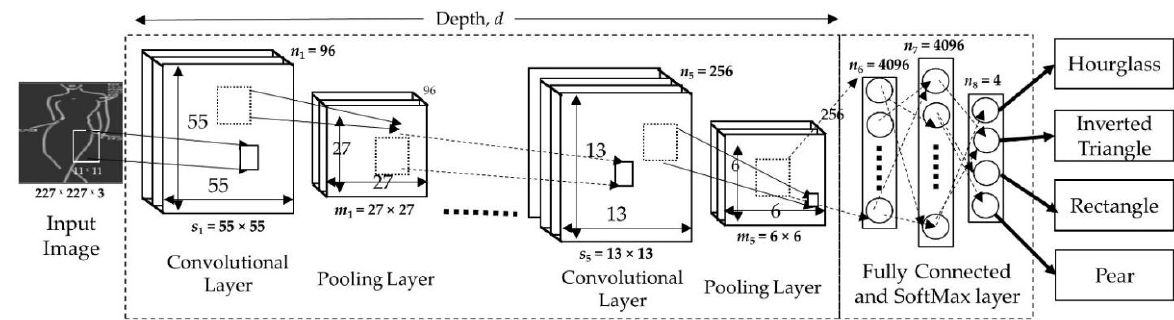
Figure 12. Training procedure of convolutional neural network (CNN).